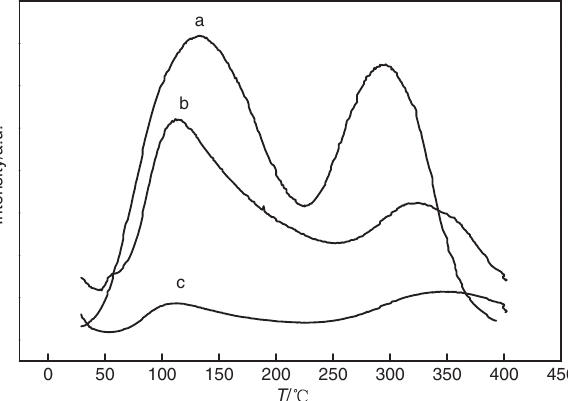
Figure 3: Thermal luminescence spectrums of (a) 70ZnO – 10P